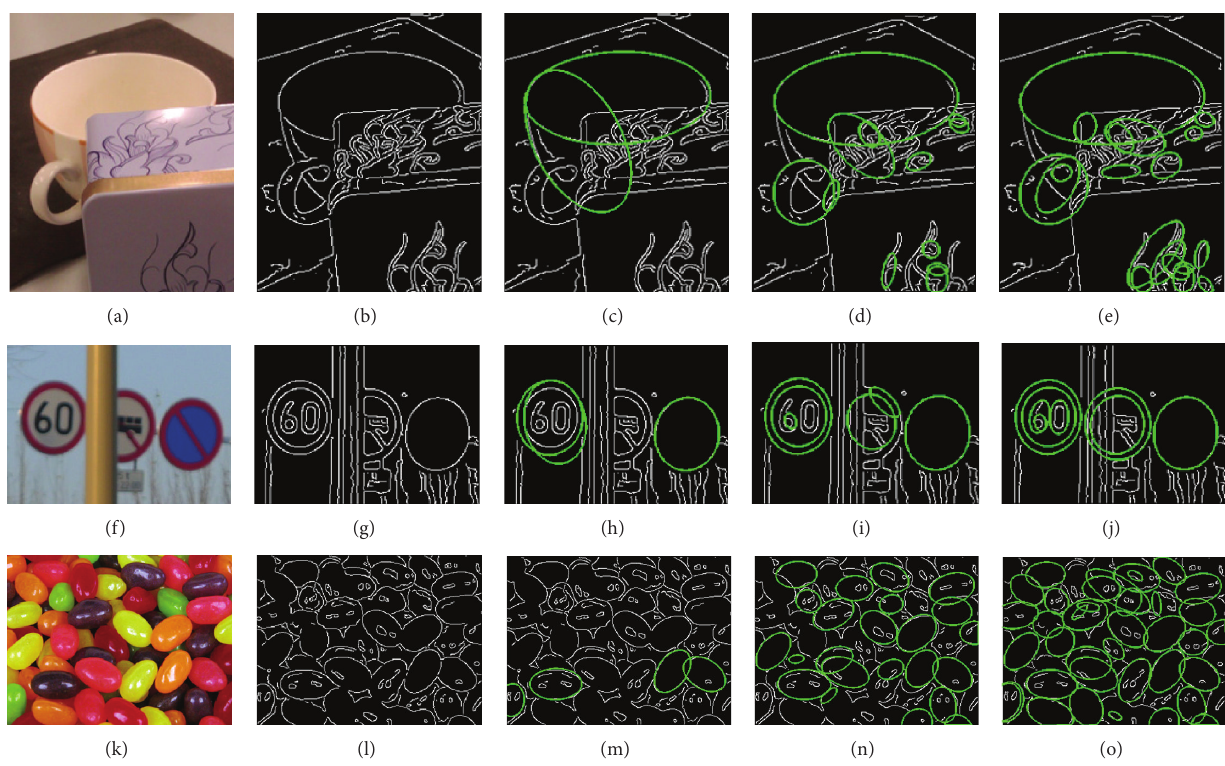
Figure 16: Detection results for real images by each method. (a, f, k) are original images, (b, g, l) are the extracted edge bitmaps, and (c, h, m), (d, i, n), and (e, j, o) are detection results by KIM, MAI, and the proposed method,